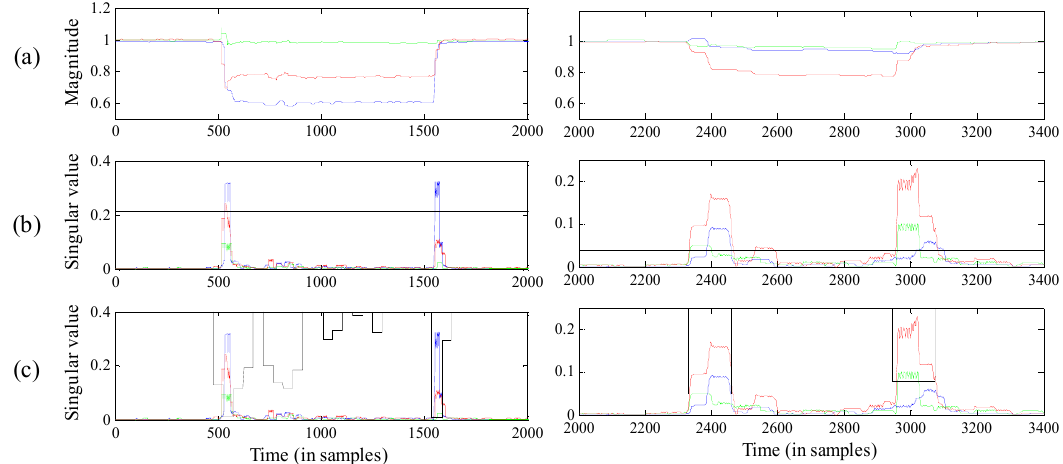
Figure 12. The segmentation results with different thresholds: ( a ) voltage magnitude; ( b ) Th1; ( c ) Th2.